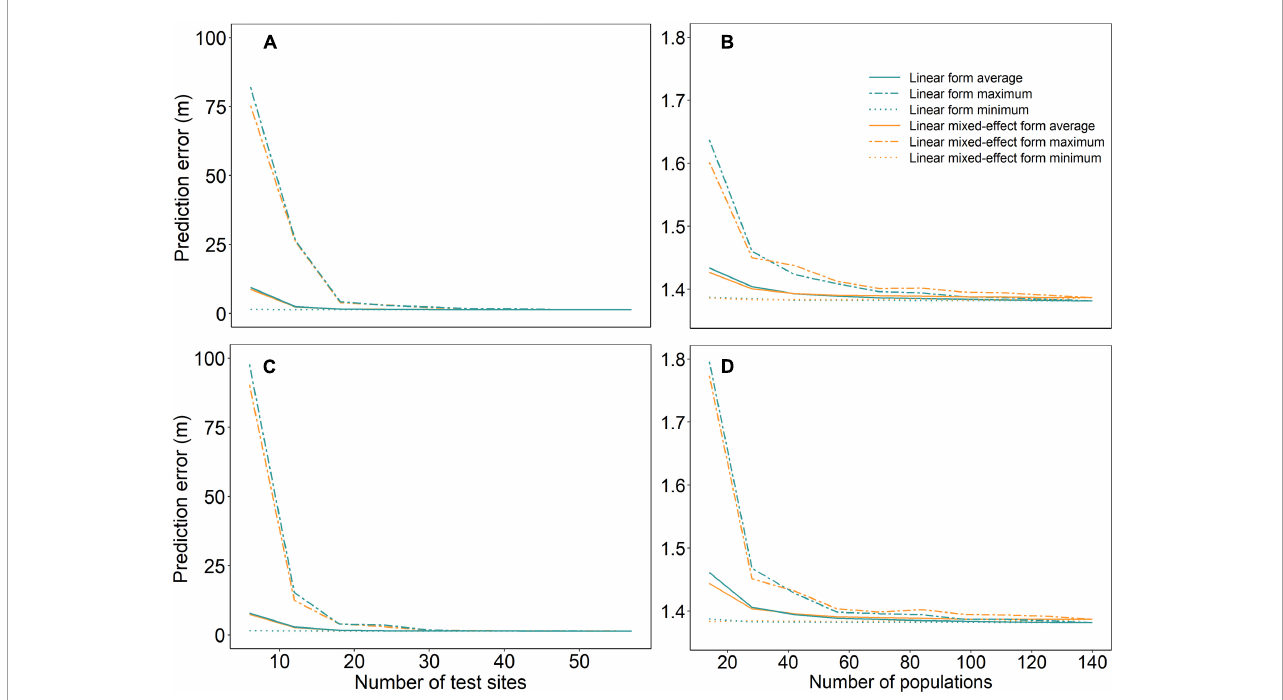
FIGURE2 Prediction errors of linear and linear mixed-effect URFs (A,B) and UTFs (C,D) with varying numbers of test sites and populations. Panels (A,C) are for a varying number of test sites, and panels (B,D) for a varying number of populations. The dash line, solid line, and dotted line represent maximum, mean, and minimum values of prediction errors, respectively, resulting from 50 repeated runs with bootstrap samples for each sample